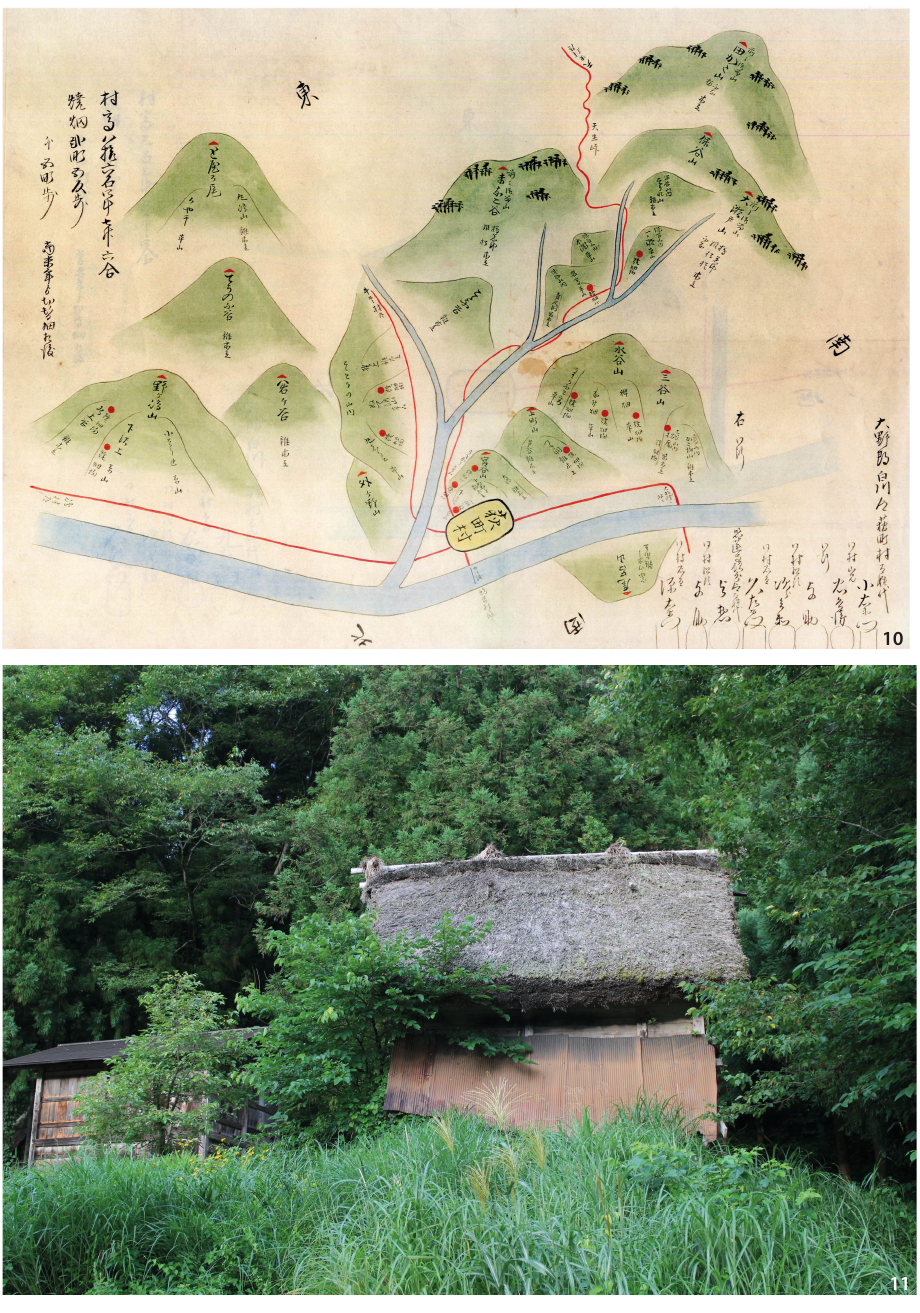
Figure 10 Tenpo Yama Ezu: Map of forest use in 1983 (Source: Shi- rakawa mura archives). Figure 11 Gassho-style